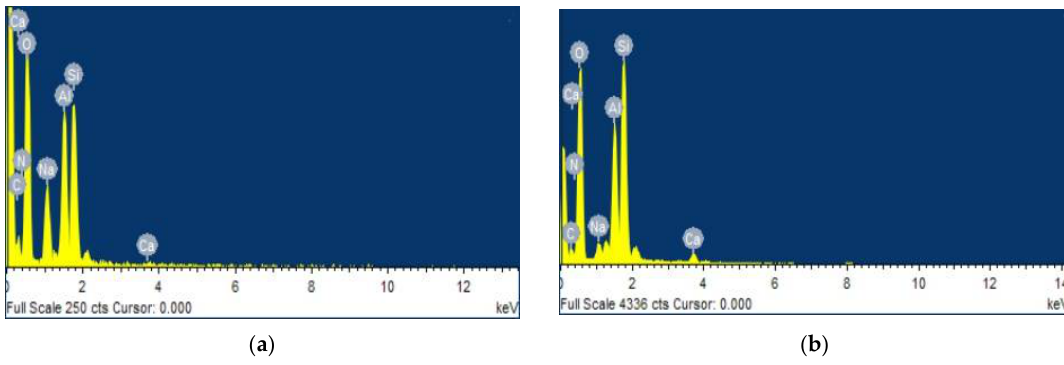
Figure 5. Energy dispersive X-ray spectroscopy (EDS) of the CTS-ZMS samples before and after ammonium nitrogen adsorption: ( a ) CTS-ZMS; ( b ) ammonium nitrogen adsorbed CTS-ZMS.